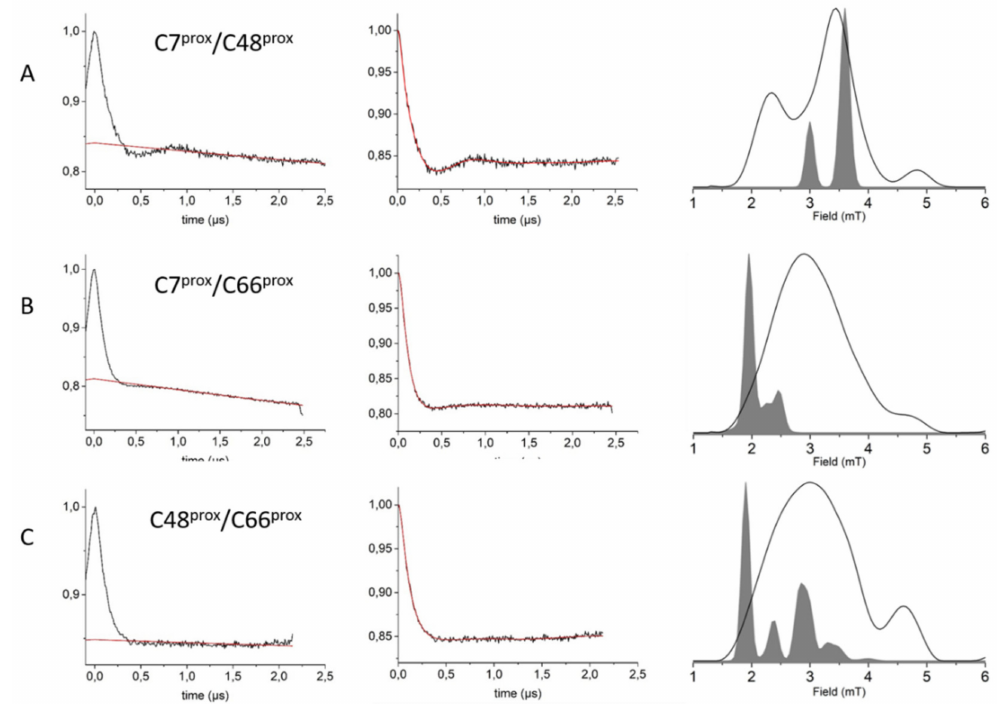
Figure 4. Inter-label distance distributions. ( Left panel ): experimental Q-band DEER traces recorded at 60 K for ( A ) C7 prox / C48 prox , ( B ) C7 prox / C66 prox , and ( C ) C48 prox / C66 prox . Red lines indicate the baseline used for background correction. ( Central panel ): corrected Double Electron-Electron Resonance (DEER) traces (black) with superimposed fits derived from Tikhonov regularization (red). ( Right panel ): Tikhonov derived distance distributions obtained using DeerAnalysis (black) [56] superimposed with distance distributions calculated by MMM software (gray curves)